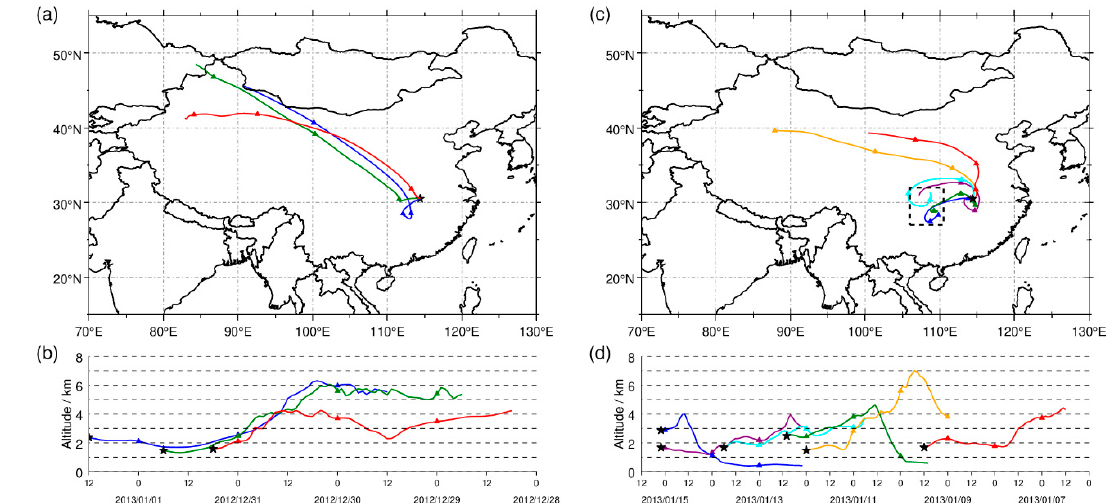
Figure 14. The 72 h backward trajectories associated with the lidar-detected EALs during the ( a , b ) clear and ( c , d ) haze period, respectively. The rectangle in panel ( c ) enclosed the source locations corresponding to the last 4 EALs during the haze period. Table 3. Statistics of the EALs and corresponding airflows during the observation period.